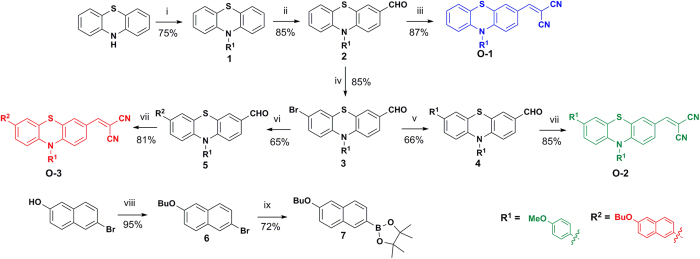
Synthesis of push-pull organic semiconductors O-1, O-2 and O-3.Reagents: (i) 4-Iodoanisole, Cu, K2CO3, TEGDME, 180 °C; (ii) POCl3, DMF, C2H4Cl2, 80 °C; (iii and (vii) CH2(CN)2, Piperidine, CHCl3, reflux; (iv) N-Bromosuccinimide, CHCl3, rt; (v) 4-methoxyphenyl boronic acid, Pd(PPh3)4, K2CO3 (2M), THF; (vi) 2-(6-butoxynaphthalen-2-yl)-4,4,5,5-tetramethyl-1,3,2-dioxoborolane, Pd(PPh3)4, K2CO3 (2M), THF; (viii) 1-bromobutane, KOH, DMSO, rt; (ix) bis(pinacolato)diboron, Pd(dppf)Cl2, KOAc, 1,4-dioxane, 80 °C.